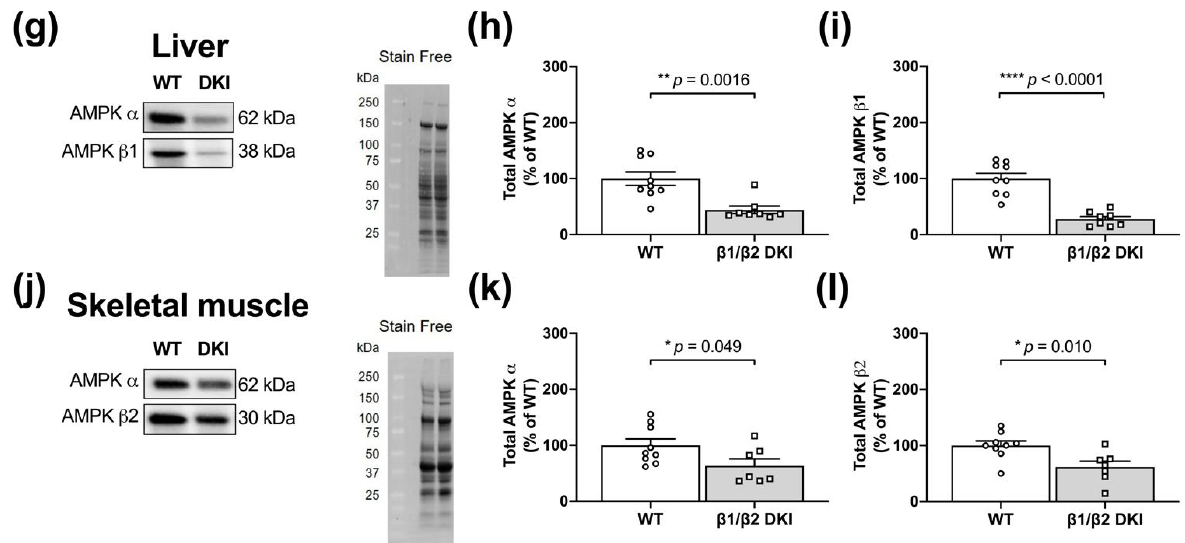
Figure 7. DKI mice have intact AMPK-acetyl-CoA carboxylase (ACC) signaling but reduced AMPK content in liver and skeletal muscle. Tissues were collected from male mice in the fed and overnight fasted states, and 5 h- and 24 h-post- administration of a glucose bolus (3.6 g · kg − 1 total body mass) via oral gavage. The 24 h-post cohort had ad libitum access to chow beginning at 5 h-post glucose gavage. Liver and skeletal muscle were collected, snap-frozen and phosphorylation status of AMPK T172 and ACC S79 was assessed. Representative immunoblots and stain-free images for DKI versus WT in ( a ) liver and ( d ) skeletal muscle. Quantified ( b ) AMPK p-T172 and ( c ) ACC p-S79 relative to respective total protein in liver. Quantified ( e ) AMPK p-T172, ( f ) ACC p-S79 relative to respective total protein in skeletal muscle. Given the predominant glycogen stores in liver and skeletal muscle, AMPK content was assessed in these tissues. Representative immunoblots and stain-free images of ( g ) liver and ( j ) skeletal muscle collected from male DKI and WT mice in the fed state. Quantified ( h ) AMPK α and ( i ) AMPK β 1 in liver, and ( k ) AMPK α and ( l ) AMPK β 2 in skeletal muscle are shown. Male mice, n = 6–9, 20–32 wk. $ p < 0.05, $$$ p < 0.001 versus fed condition from same genotype; * p < 0.05, ** p < 0.01, *** p < 0.001, **** p <